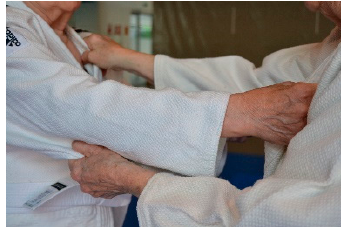
Figure 8. Grip, working in pairs.